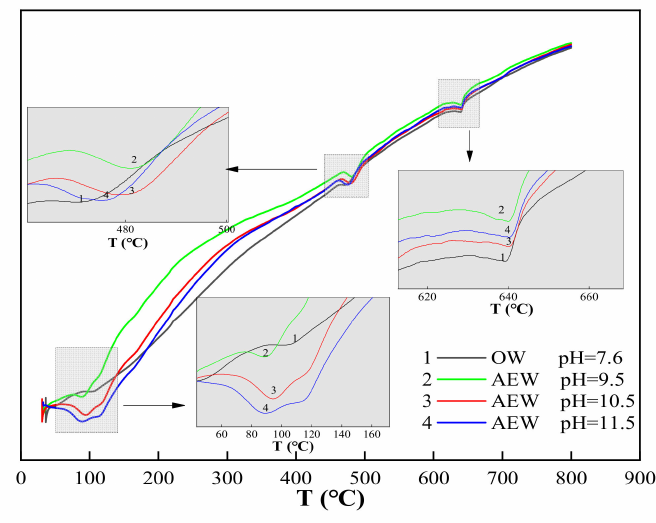
Figure 9. Detailed analysis diagram of Figure